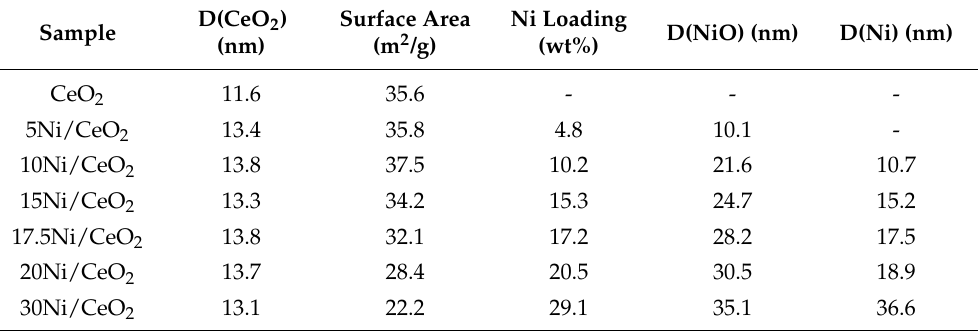
Figure 1. ( A ) XRD patterns of calcined xNiO/CeO 2 samples; ( B ) the enlarged pattern at the range of 26 – 31°. Table 1. The surface areas ( S BET ), Ni loading, and average crystallite sizes of CeO 2 , NiO, and metallic Ni in the reduced